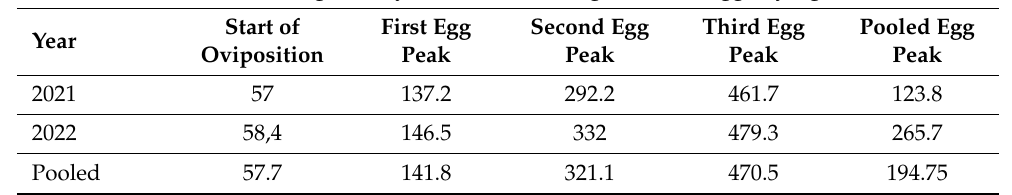
Table 1. Ordinal (linear) heat summation (degree-days) risk thresholds of reproductive 3.4. Suitability of weather conditions and heat